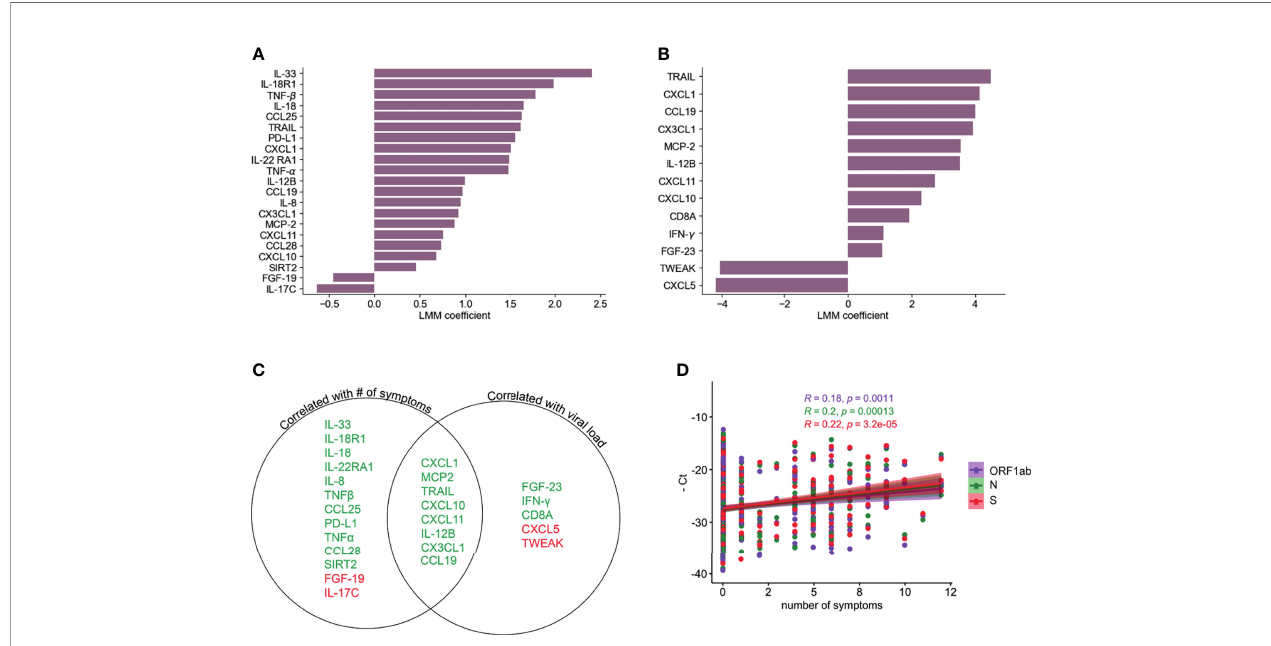
FIGURE 3 | Correlation of PEA serum markers with symptoms and viral load. LLM correlation analysis of PEA detected markers and number of symptoms (A) and relative viral load determined as the average of the negative Ct values of S, N and ORF1ab genes (B) FDR cutoff = 0.05. (C) Venn diagram showing the serum markers that are correlated with number of symptoms and/or viral load. Green denotes positive correlation and red denotes negative correlation. (D) Correlation (Pearson ’ s) between PCR negative Ct values for ORF1ab, N and S genes and numbers of